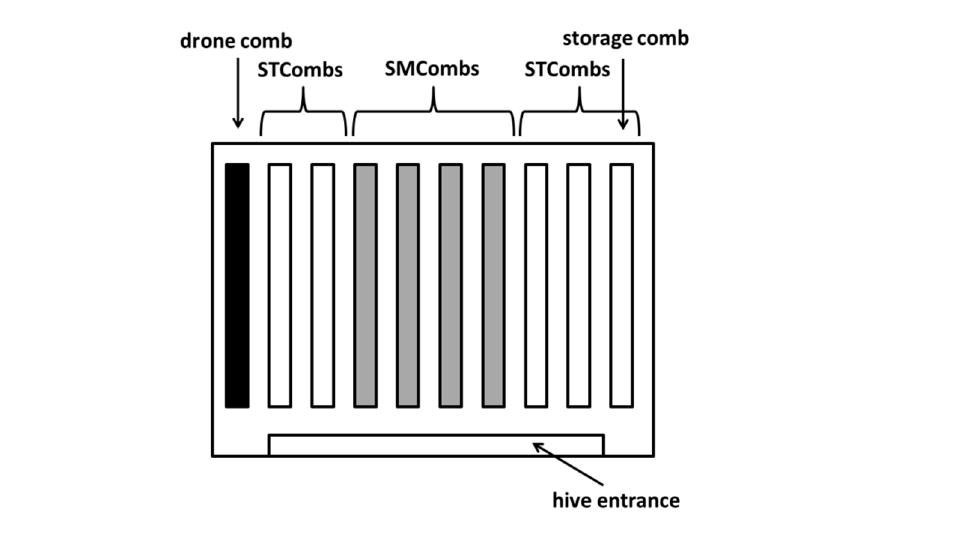
Figure 1. Scheme of the arrangement of the combs in the colony brood-chamber. SMCombs—small- cell combs; STCombs—standard-cell combs.